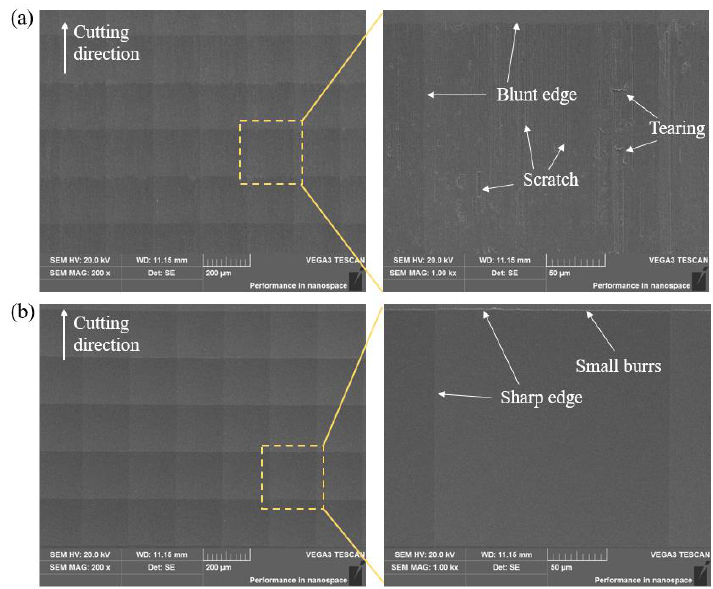
Figure 10. SEM of the surface morphology for the microlens array machined by: ( a ) CS, ( b )